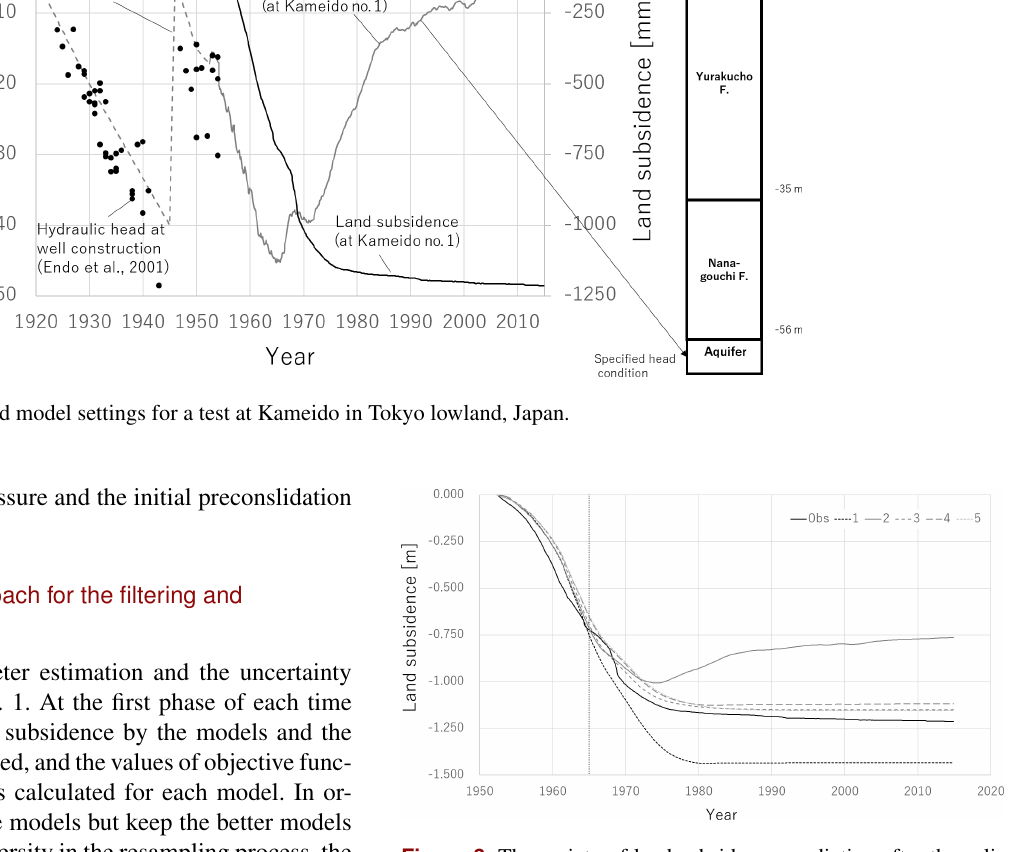
Figure 3. The variety of land subsidence prediction after the cali- bration in December